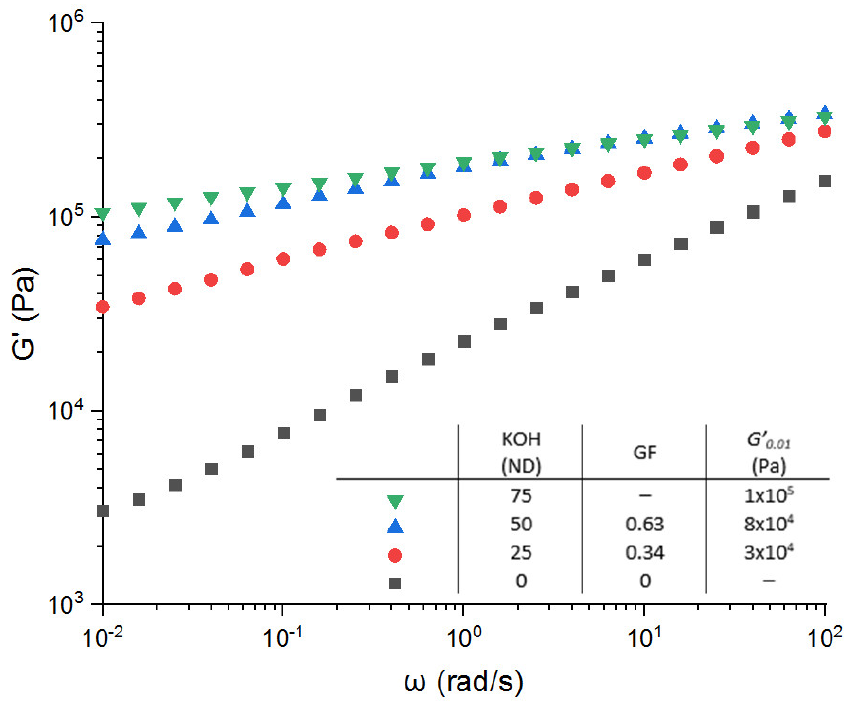
Figure 4. Variation of the storage modulus versus angular frequency for the EPDM-g-MA crosslinked with different neutralization degree of KOH. No DCP has been added in these formulations.